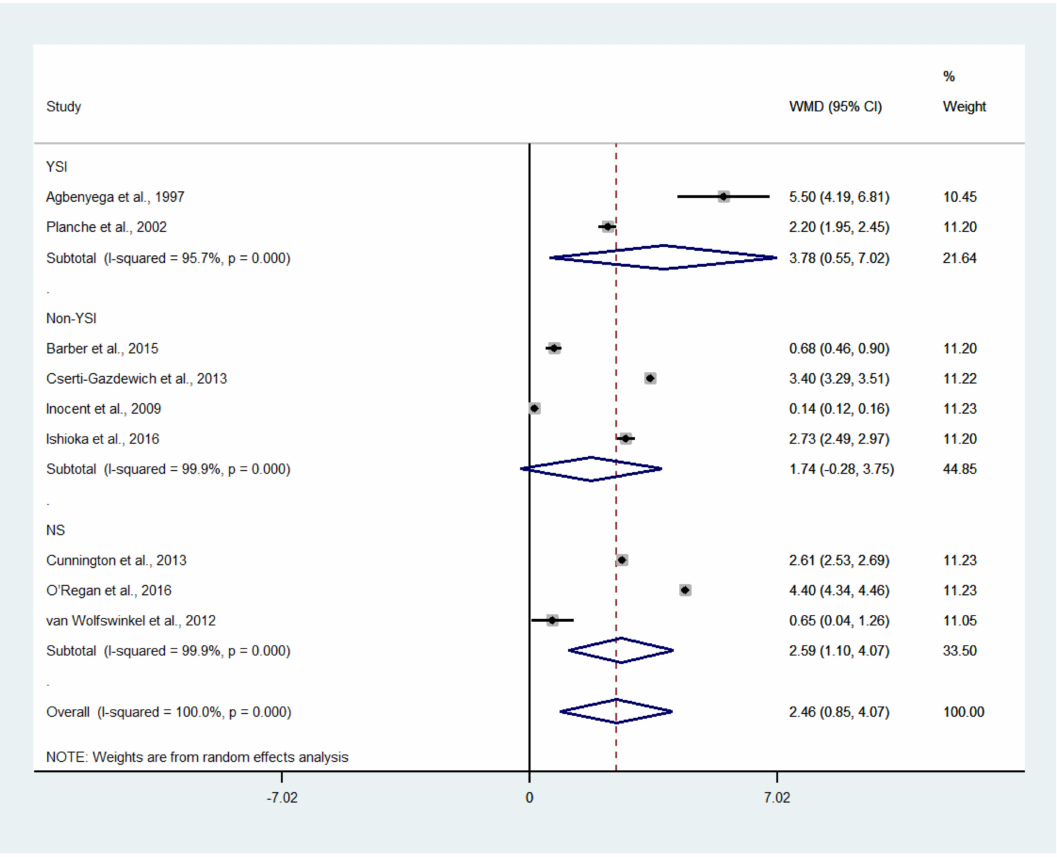
Figure 8. The difference in mean lactate level between patients with severe and uncomplicated malaria according to analyzers. Abbreviations: WMD, weighted mean difference; CI, confidence interval.